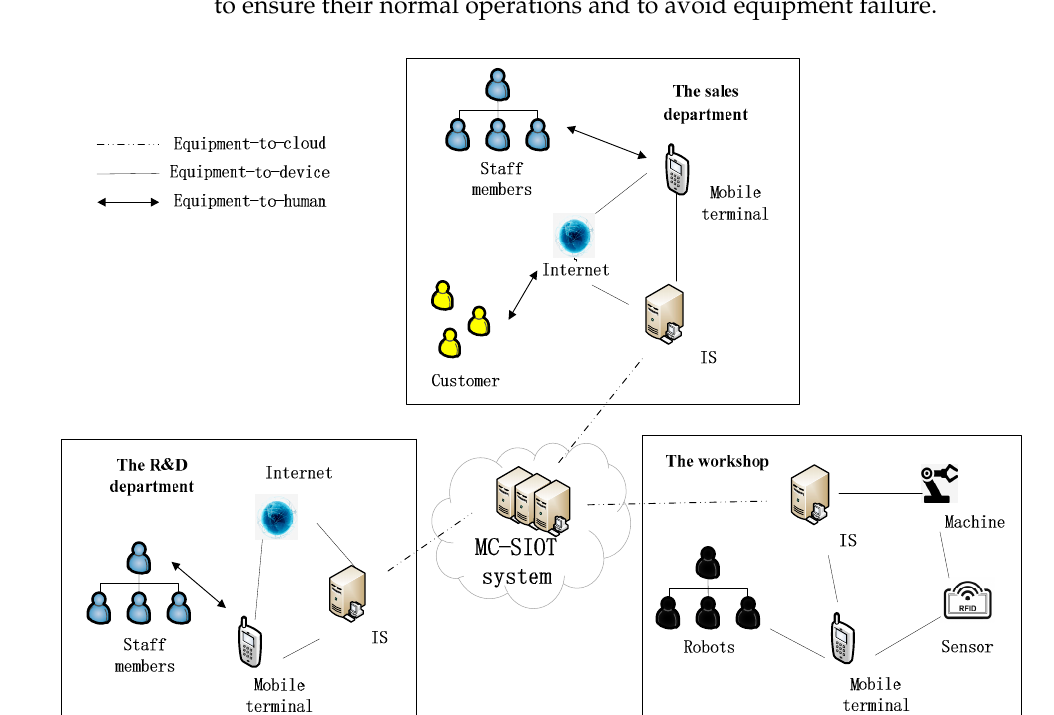
Figure 3. The organizational architecture of the MC–SIOT system.